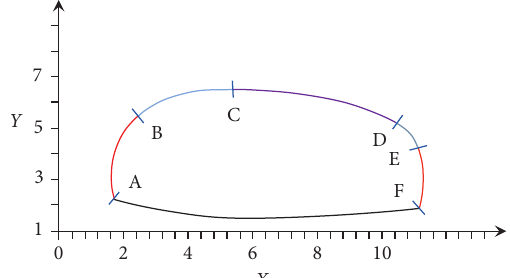
Figure 4: A shape of the transverse-vertical cross section of the orthopedic boot-tree on 0.8 D .